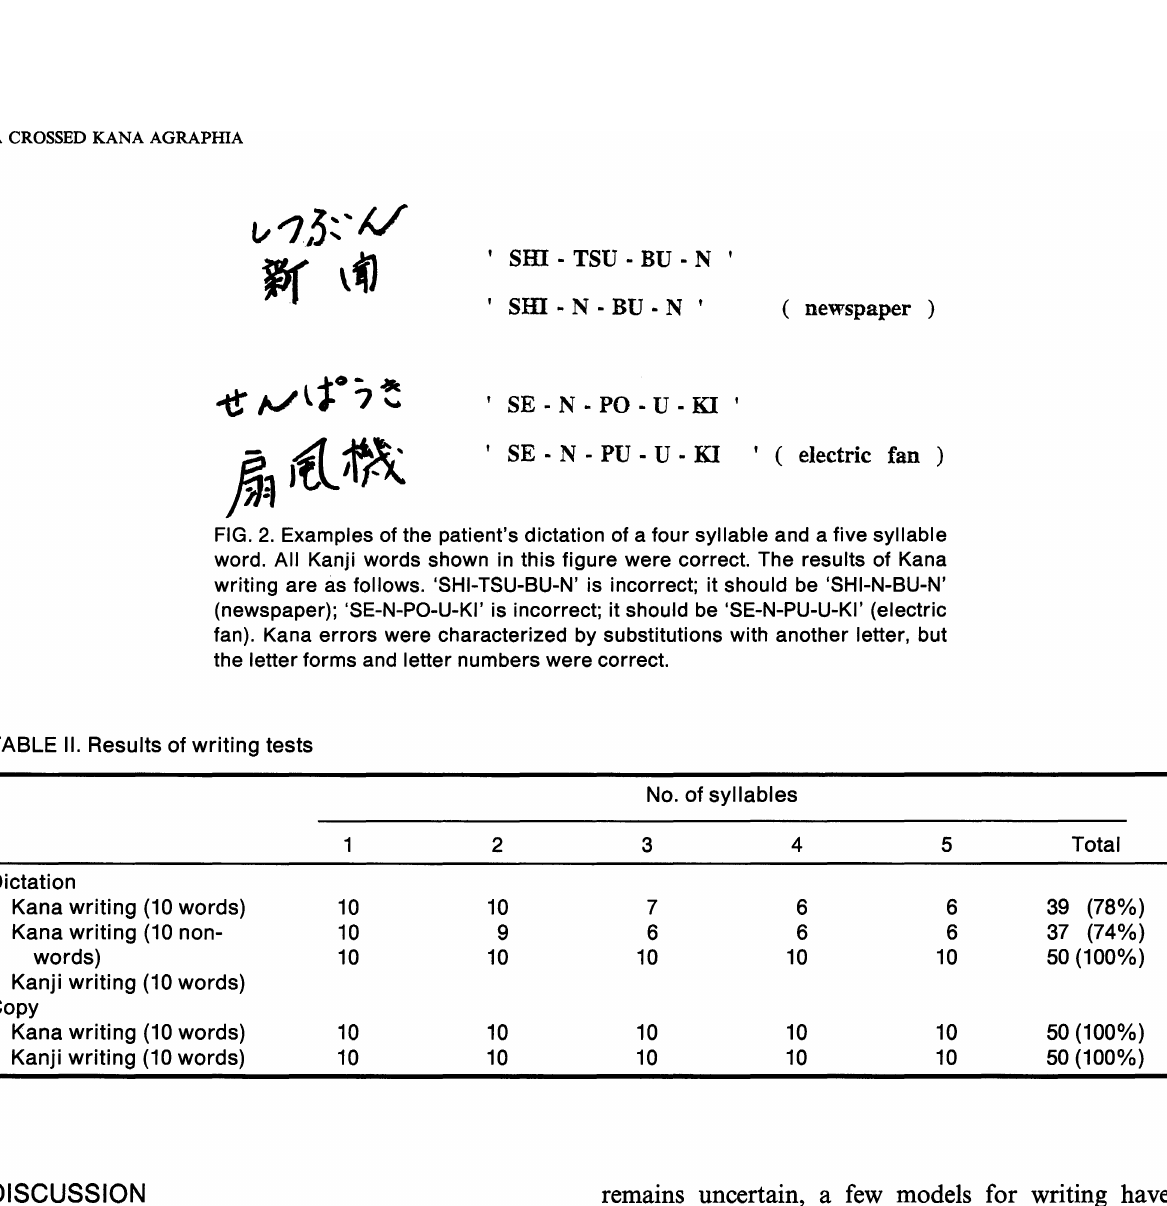
TABLE II. Results of writing tests